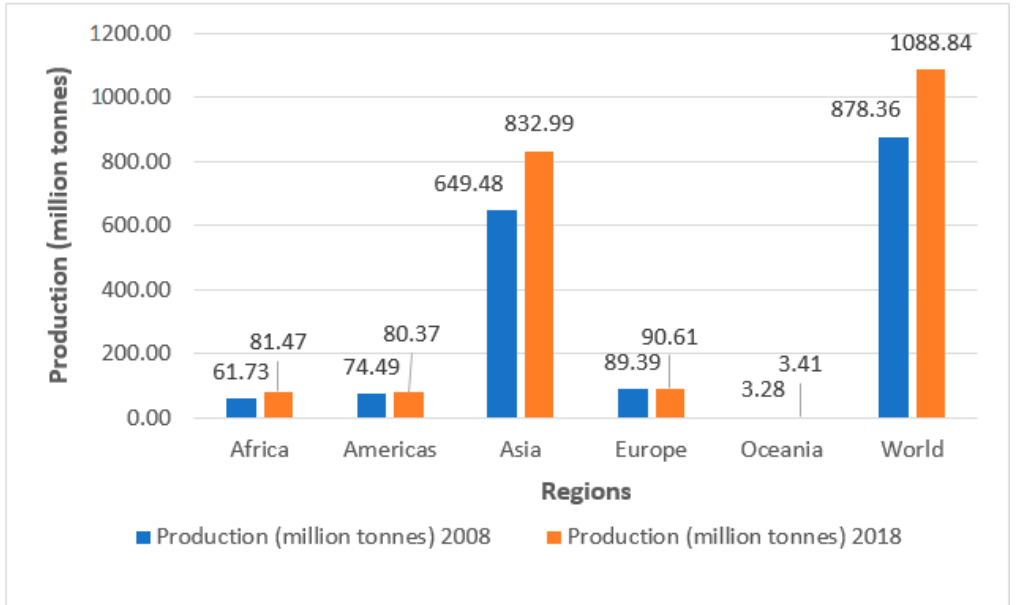
Figure 1. Comparison of global production of primary vegetables in 2008 and 2018, by major regions (Source: Statistics Division of FAO. Available online: http://www.fao.org/faostat/en/#data/QC/